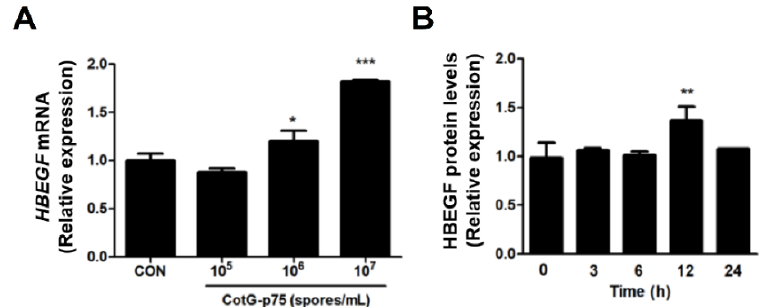
Figure 12. Effects of CotG-p75 on CCL20 mRNA expression ( A ) and CCL20 protein production ( B ) in Caco-2 cells. In panel ( A ), cells were treated with various concentrations (10 5 , 10 6 , and 10 7 spores/mL) of CotG-p75 for 3 h. In panel ( B ), cells were treated with CotG-p75 (10 7 spores/mL) for various time periods (0, 3, 6, 12, and 24 h). Both mRNA expression levels and protein production levels in treated groups were compared with those of the control group. All data are expressed as mean ± standard deviation ( n = 3). Asterisks (*) indicate a significance difference from the control (*, p < 0.05; **, p < 0.01; ***, p < 0.001).